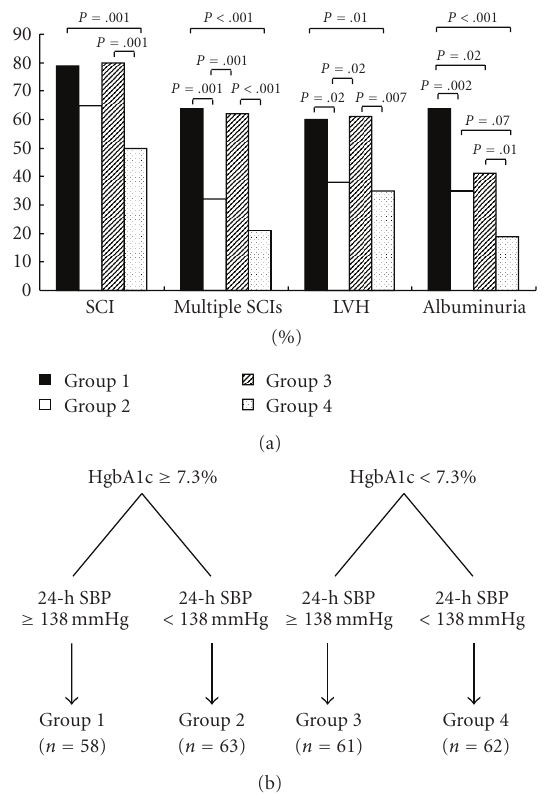
Figure 2: (a) Prevalence of hypertensive target organ damage in each group. SCI = silent cerebral infarct; multiple SCIs = three or more lesions; LVH = left ventricular hypertrophy; P -values noted above bars (adopted from [8]). (b) Classification of the subjects based on the median values of ambulatory systolic blood pressure (SBP) and glycosylated hemoglobin